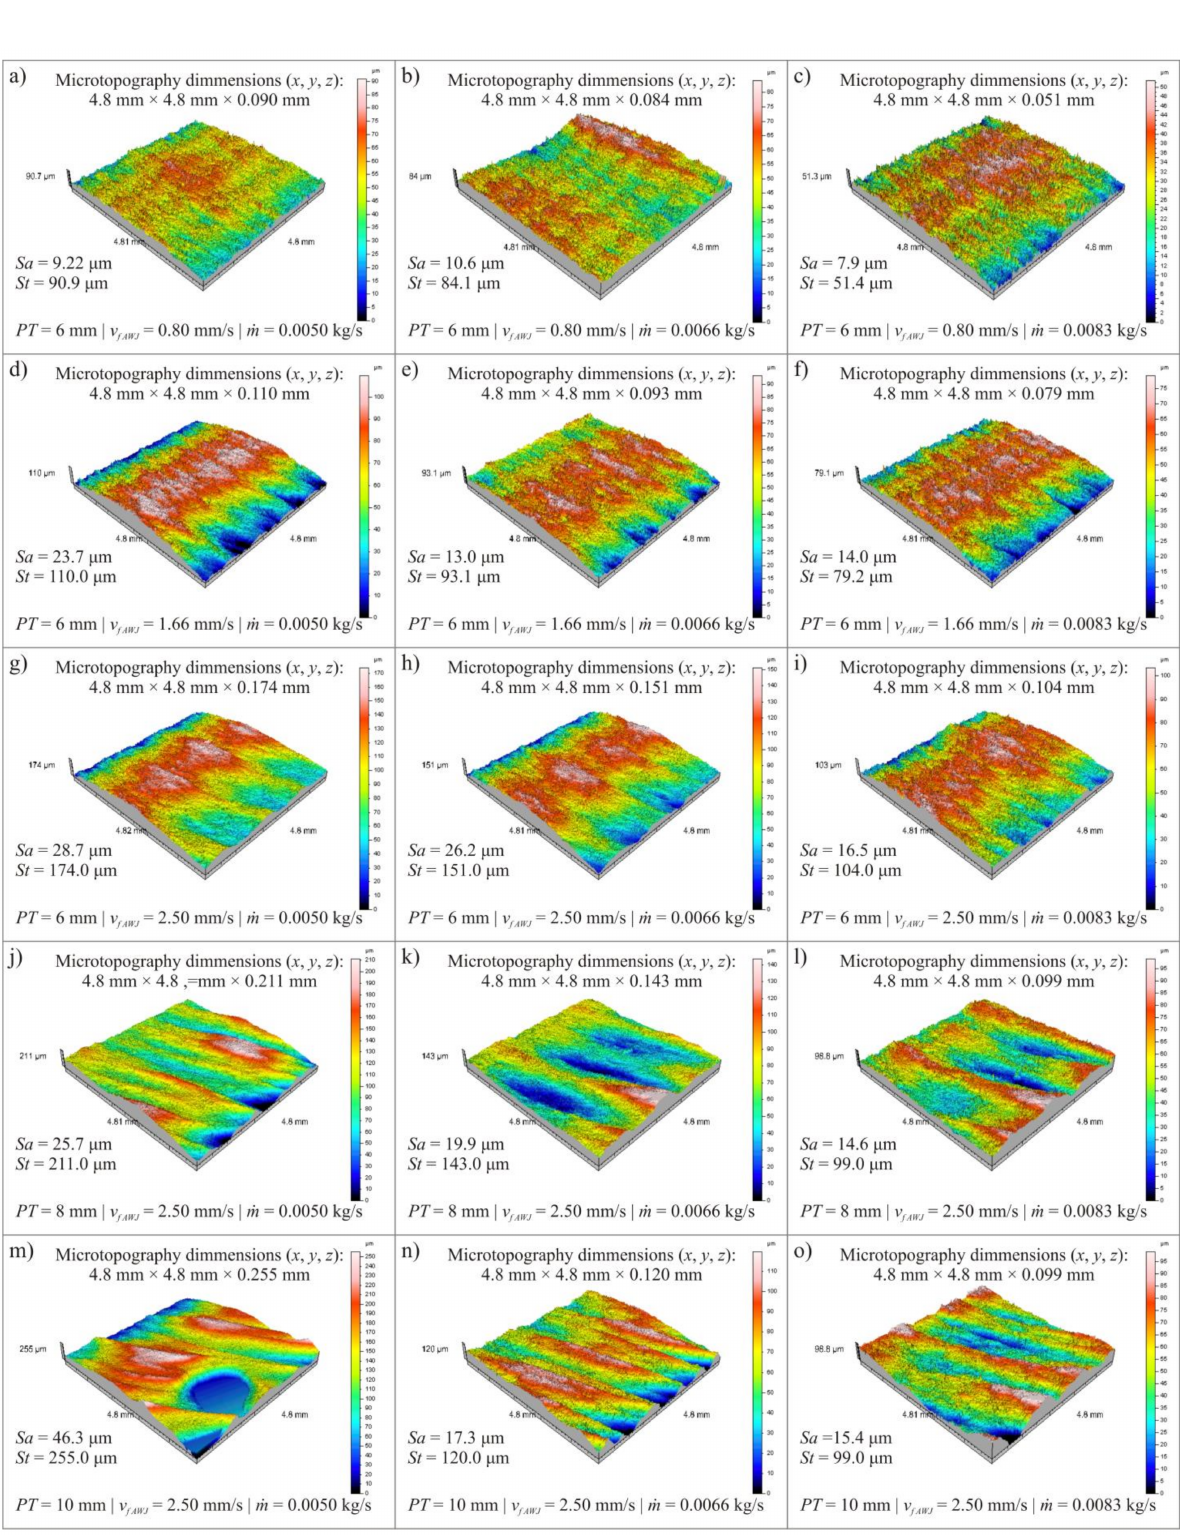
Figure 3. An overview of selected microtopographies of cut surfaces of elements cut by abrasive water jet: ( a – i ) PT = 6 mm, v f AWJ = 0.80; 1.66; 2.5 mm/s, ˙ m = 0.0050, 0.0066, 0.0083 kg/s; ( j – l ) PT = 8 mm, ˙ m = 0.0050, 0.0066, 0.0083 kg/s, v f AWJ = 2.50 mm/s; ( m – o ) PT = 10 mm, ˙m = 0.005, 0.0066, 0.0083 kg/s, v f AWJ = 2.50